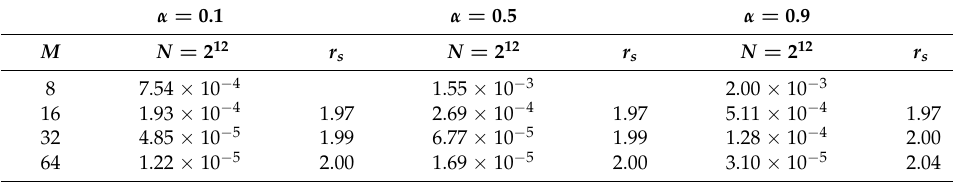
Table 2. Spatial convergence orders under different α